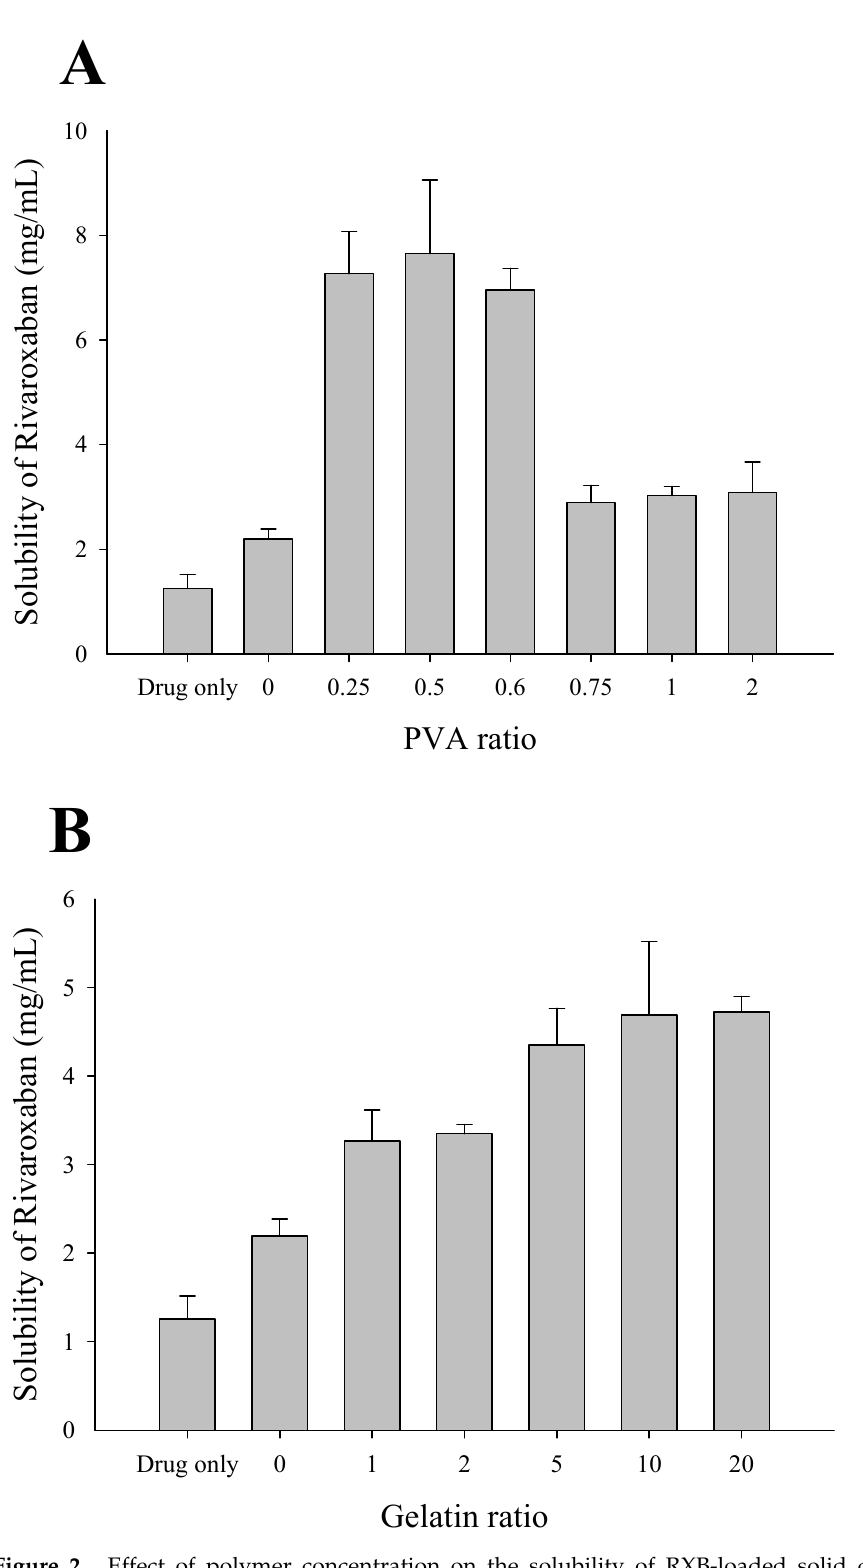
Figure 2. Effect of polymer concentration on the solubility of RXB-loaded solid dispersions. ( A ) Polyvinyl alcohol (PVA). ( B ) Gelatin. Each value shows the mean ± S.D. ( n = 3).